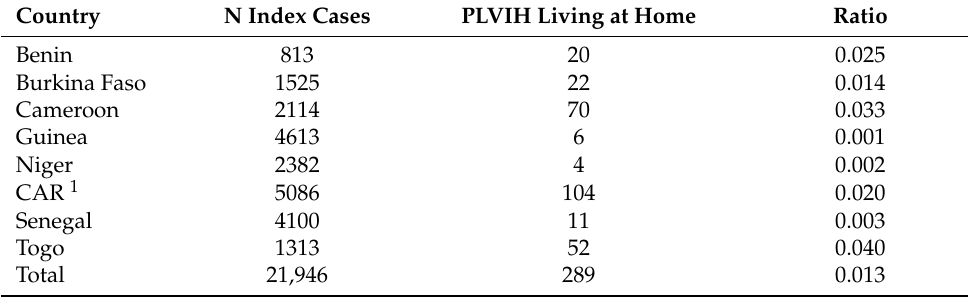
Table 5. Ratio of the number of PLHIV living at home to the number of index cases. Country N Index Cases